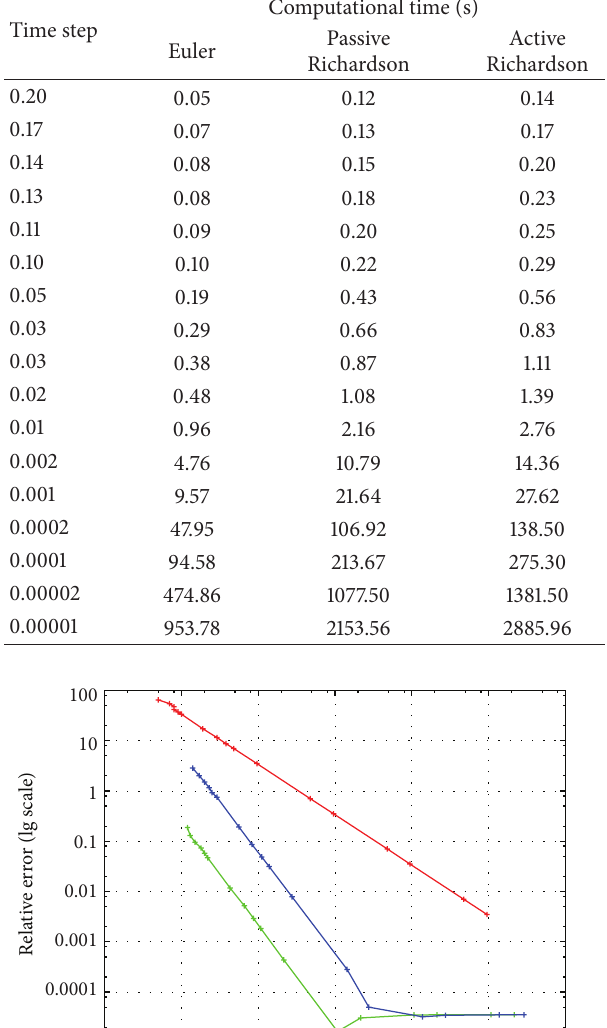
Table 2: Computational times of the diffusion problem without and with passive/active Richardson extrapolation.